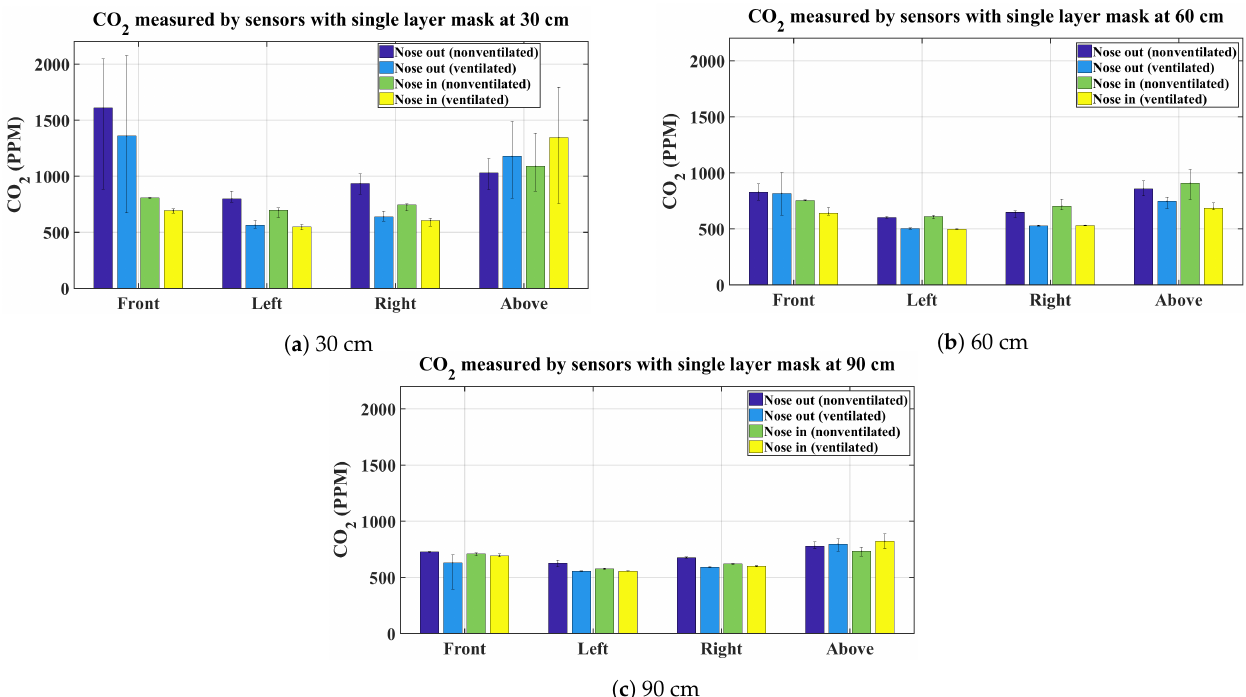
Figure 3. Average CO 2 measurements using a single layer mask.